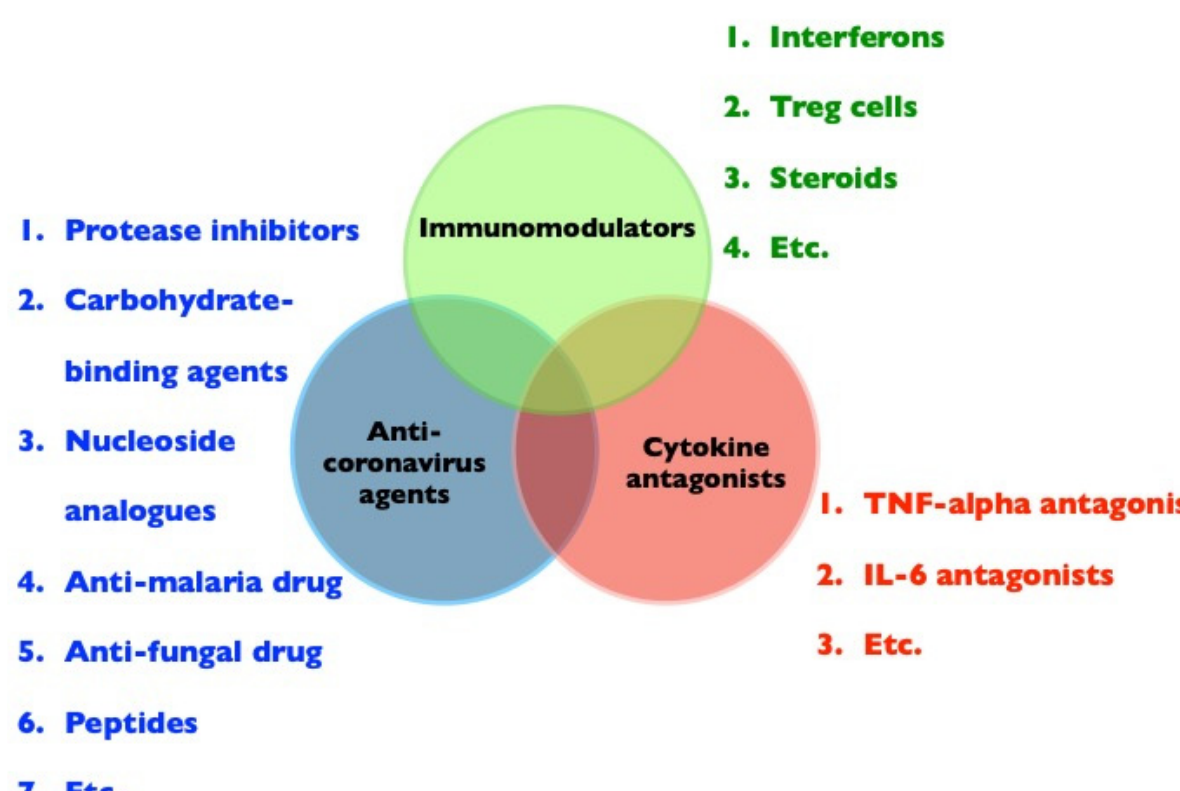
Figure 3. Potential treatment approaches for immunopathogenic diseases, such as FIP or COVID-19, including anti- coronavirus agents, cytokine antagonists, and immunomodulators.